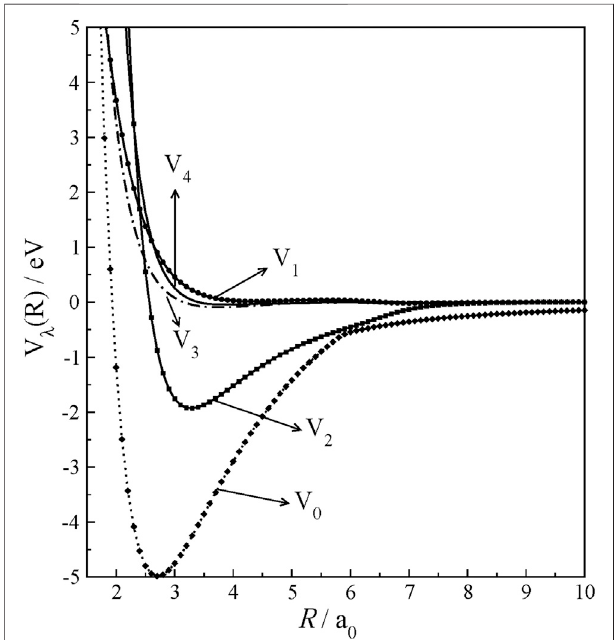
FIGURE 3 | Radial multipolar expansion coef fi cients of HCN + rigid-rotor potential as a function of R at r (cid:1) r eq .